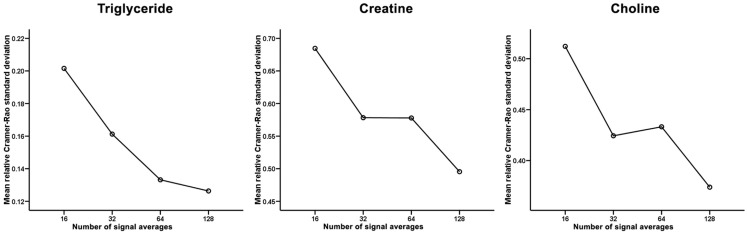
Mean relative Cramer–Rao standard deviation for the intramyocardial triglyceride, creatine, and choline. Increasing signal averages resulted in progressively lower relative Cramer–Rao standard deviation and therefore a higher signal-to-noise ratio.